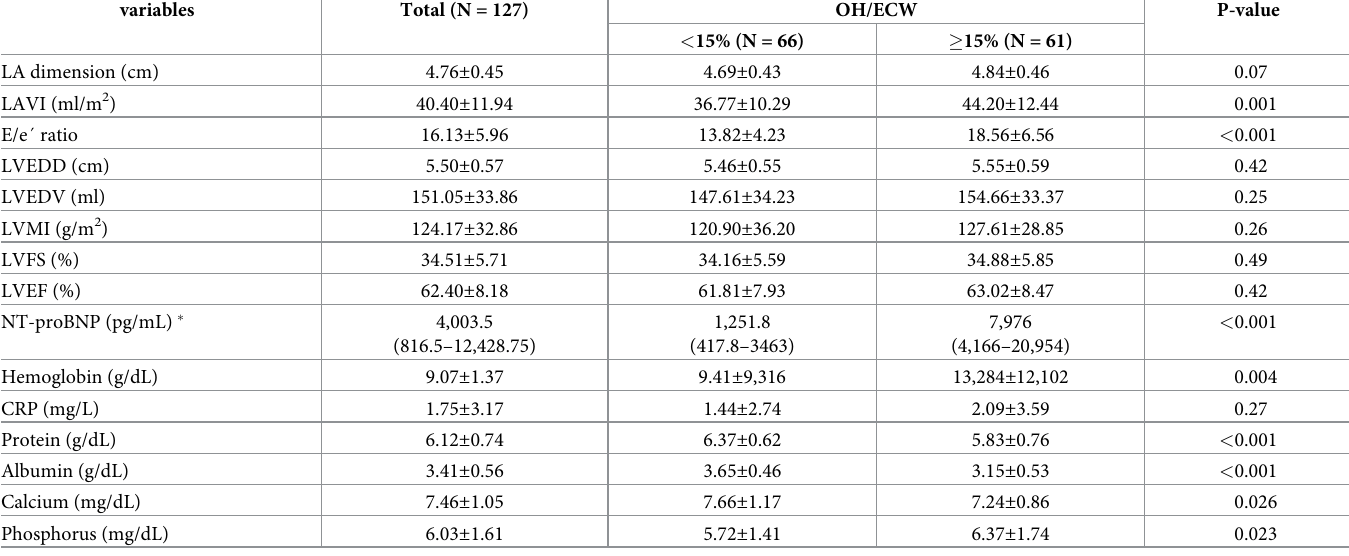
Table 2. Comparison of CKD patients with and without volume overload according to binary OH/ECW.